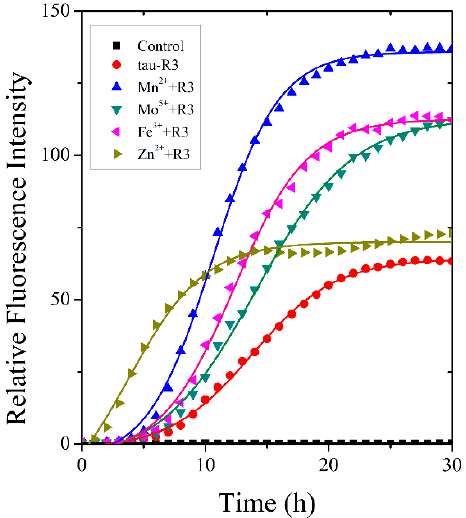
Figure 3. Metal ions altered tau-R3 fibrillization kinetics. 150- μ M tau-R3 was incubated with 10 μ M of cation (Mn 2+ , Mo 5+ , Fe 3+ or Zn 2+ ) or no cation. The buffer used was 50 mM of Tris-HCl buffer (50 mM Tris-base + 100 mM of NaCl, pH 7.4) containing 16 µ M of heparin, and 20 µ M of ThT. Solid lines represent fits of the data to the Boltzmann equation. λ ex = 440 nm, λ em = 485 nm.